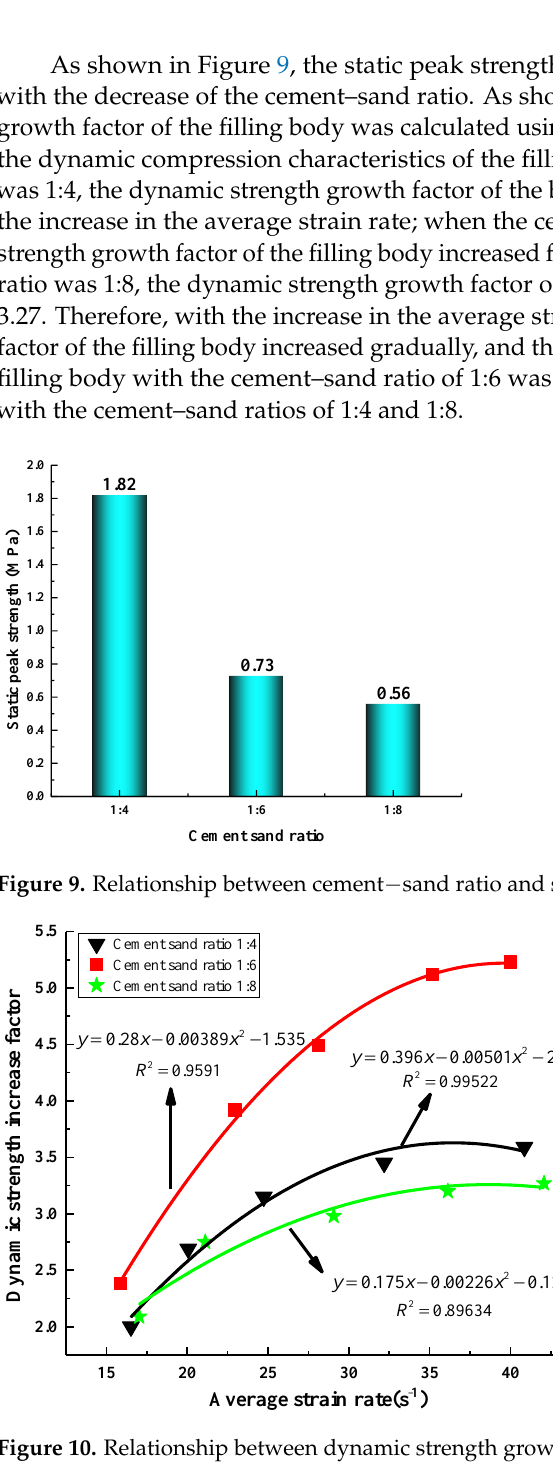
Figure 8. Relationship between average strain rate and dynamic peak stress.